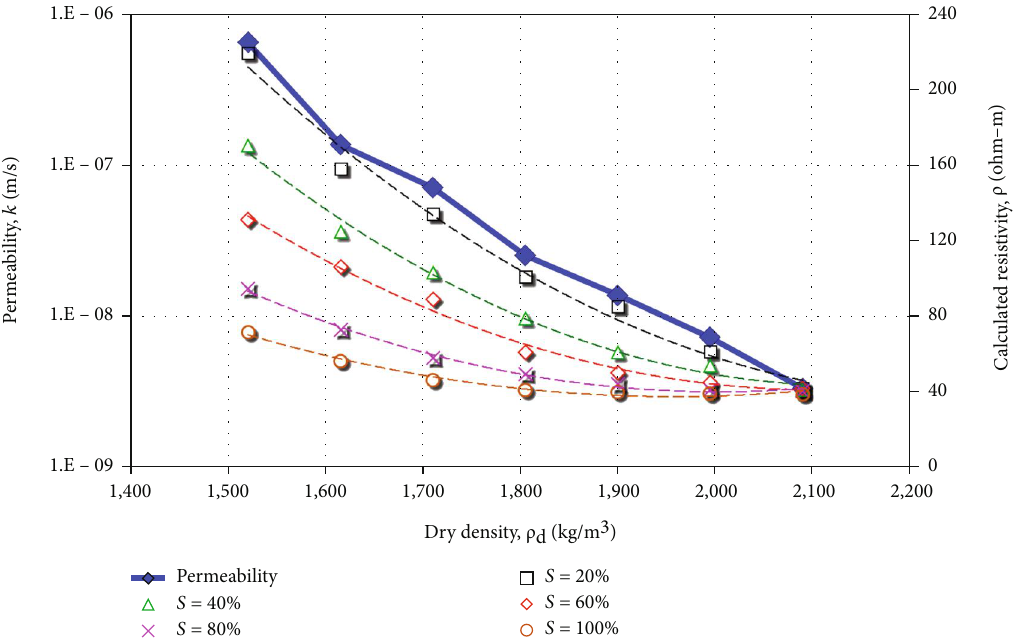
Figure 20: Results of laboratory tests on samples of matrix material from the Hattian Bala landslide dam, including permeability tests at di ff erent densities (plotted on a semilogarithmic scale on the primary vertical axis), and resistivity at di ff erent densities and degrees of saturation (on the arithmetic scale on the secondary vertical